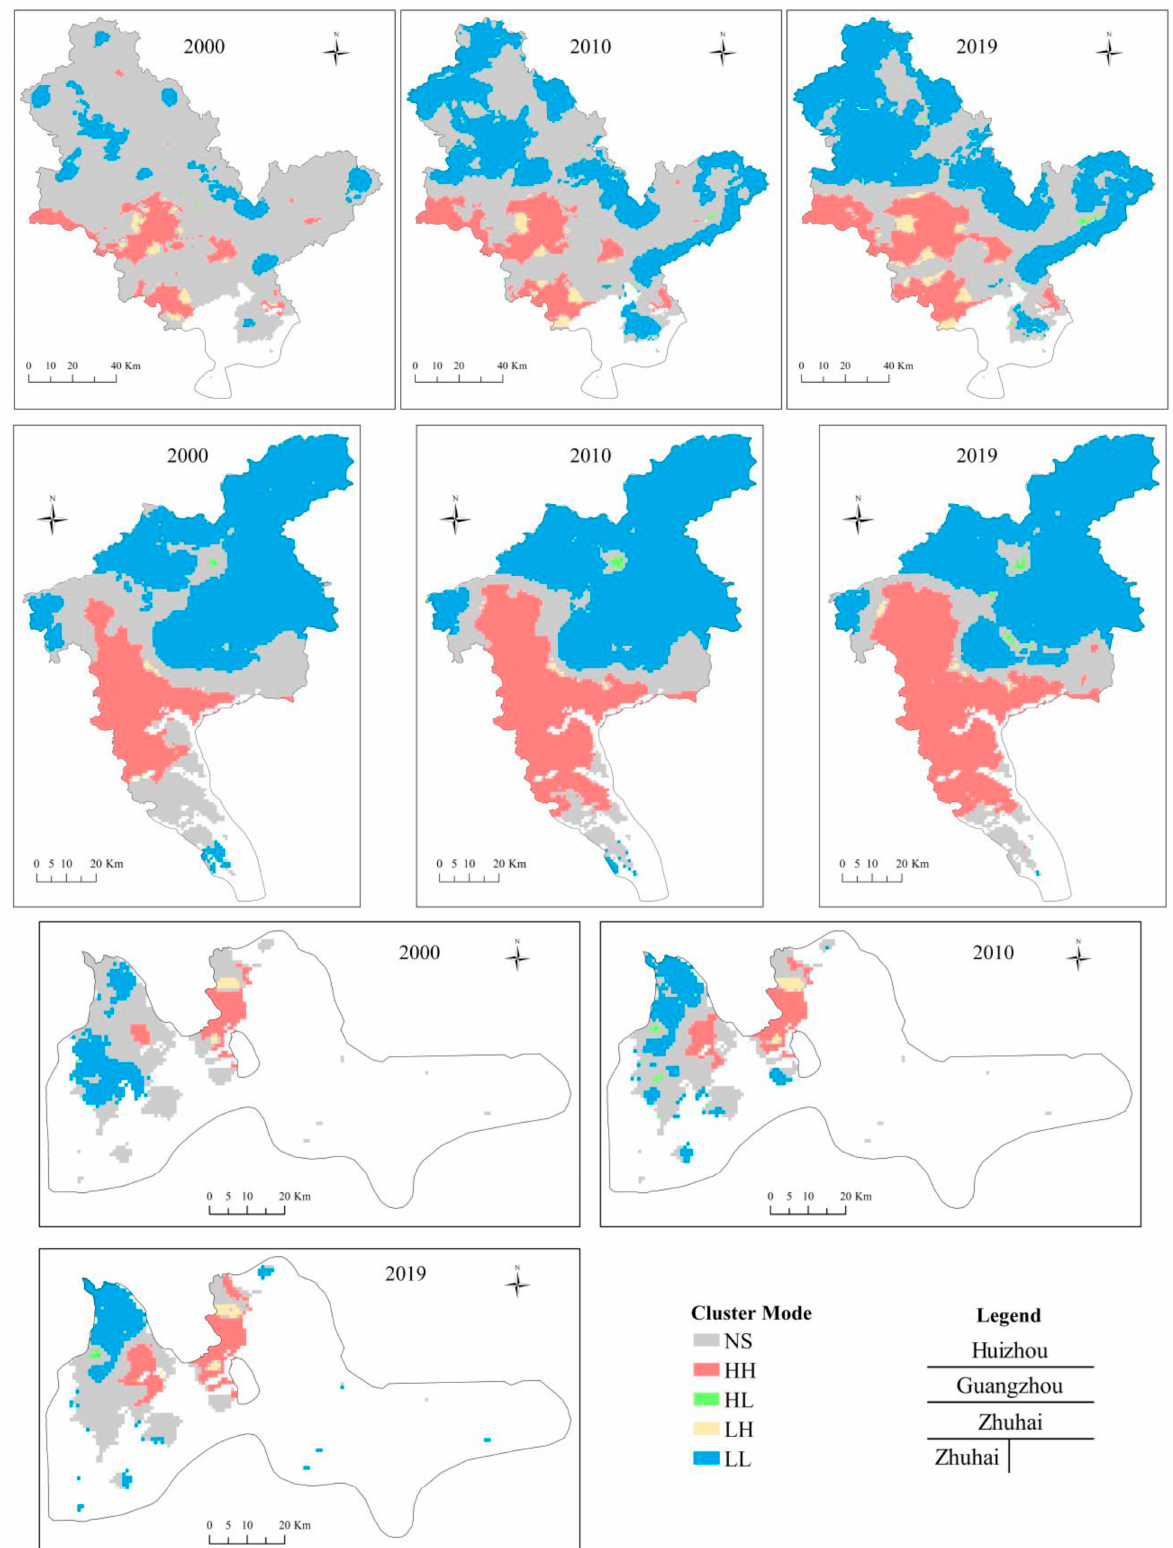
Figure 10. Annual changes of global Moran’s I: ( a ) 2000 and ( b ) 2019 in the study area. Figure 11 shows the temporal variation of the ISA% in different cities from 2000 to 2019. Rapid growth occurred in Guangzhou and Foshan, corresponding to their high rate